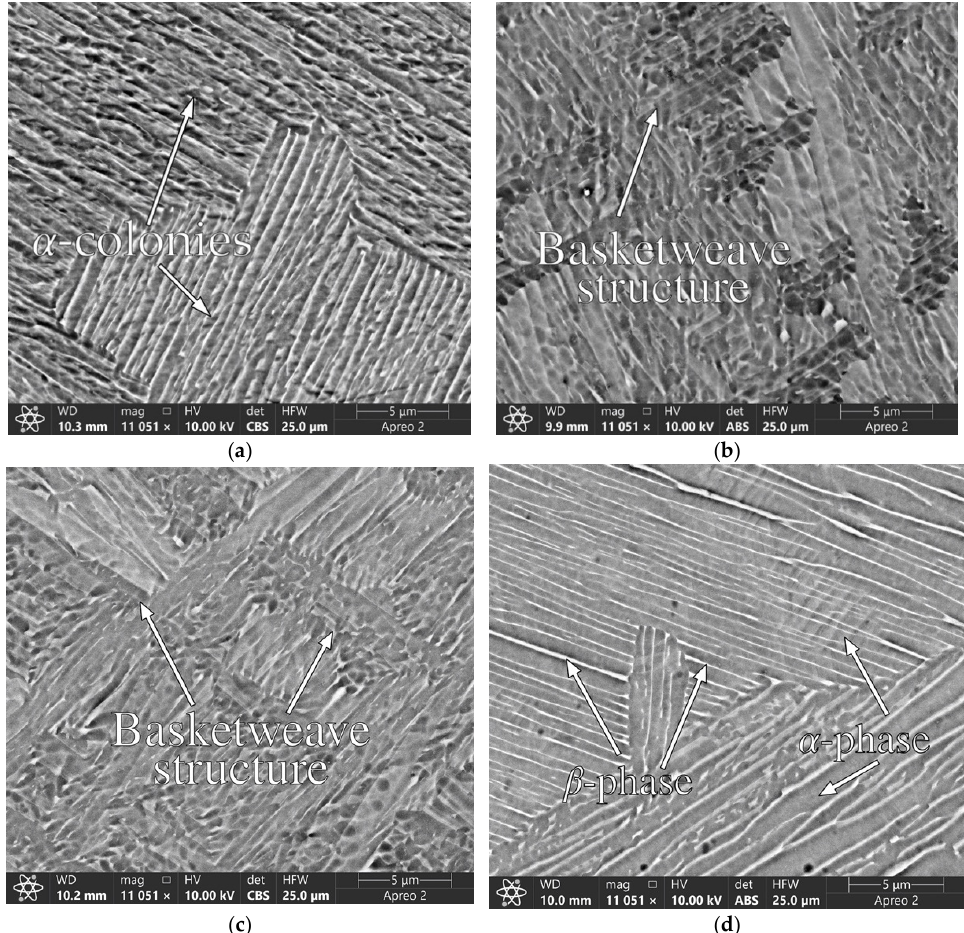
Figure 4. Base metal microstructure of samples 1 ( a ), 2 ( b ), 3 ( c ) and 4 ( d ) captured in backscattered electron mode.